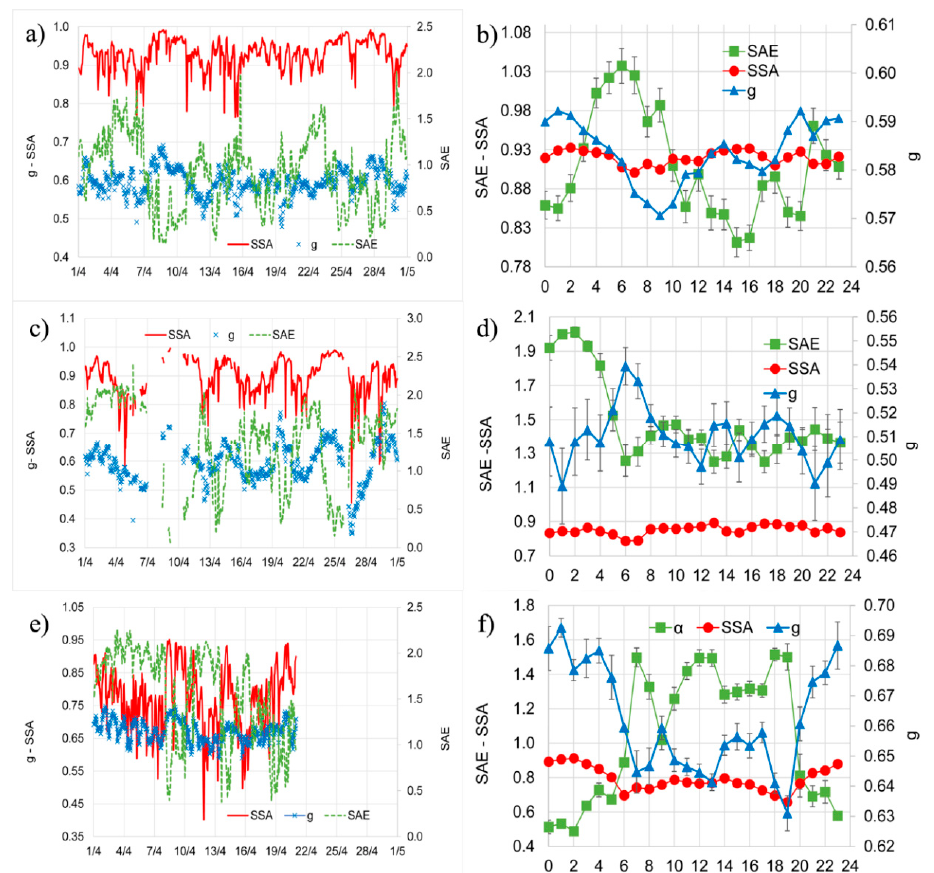
Figure 4. Time series (local time: UTC+1) of hourly average values of SAE, SSA, and asymmetry parameter at three observatories. ( a ) CGR, ( c ) LMT, and ( e ) ECO, respectively. Diurnal variation (local time: UTC+1) for SAE, SSA, and g during the whole measurement campaign at ( b ) CGR, ( d ) LMT, and ( f ) ECO. Error bars represent the standard error (standard deviation of the mean).